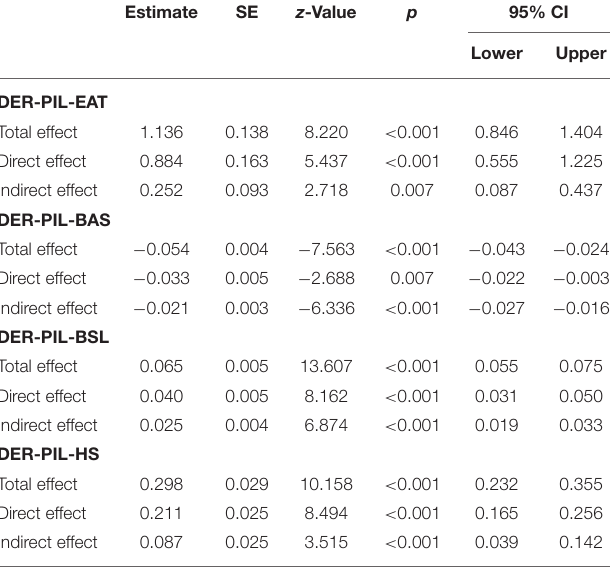
TABLE 7 | Multiple mediation model of meaning in life between emotional dysregulation and the psychopathology of eating disorders in participants with eating